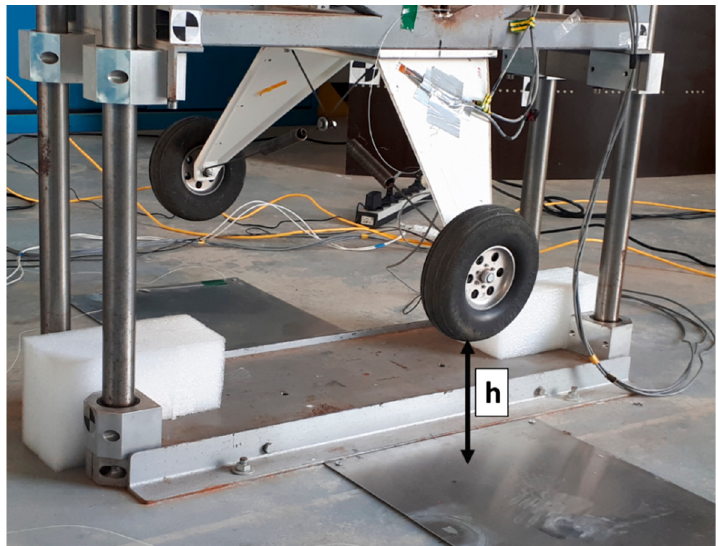
Figure 12. Test article placed at the generic height h .